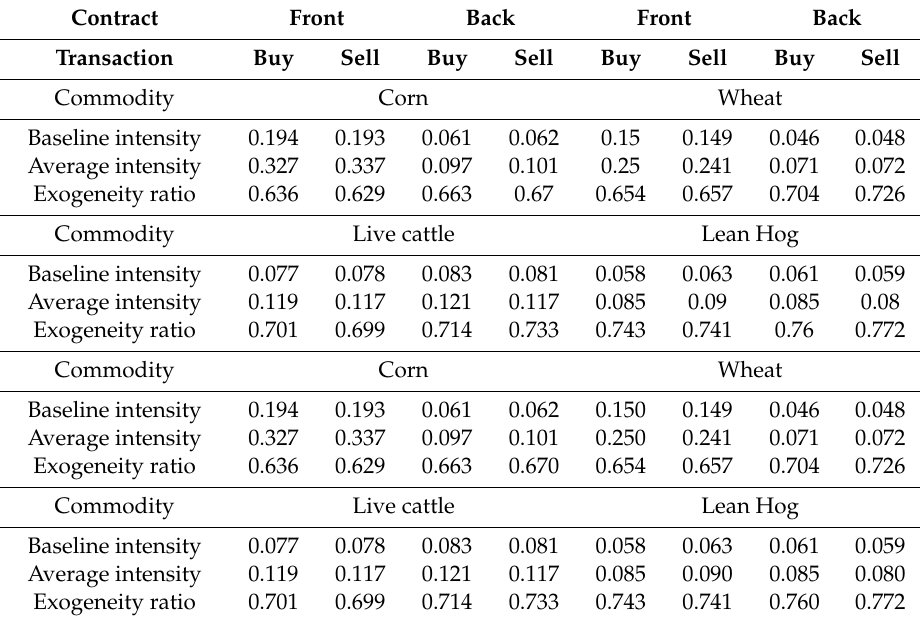
Table 2. Estimated baseline intensities, average intensities, and exogeneity